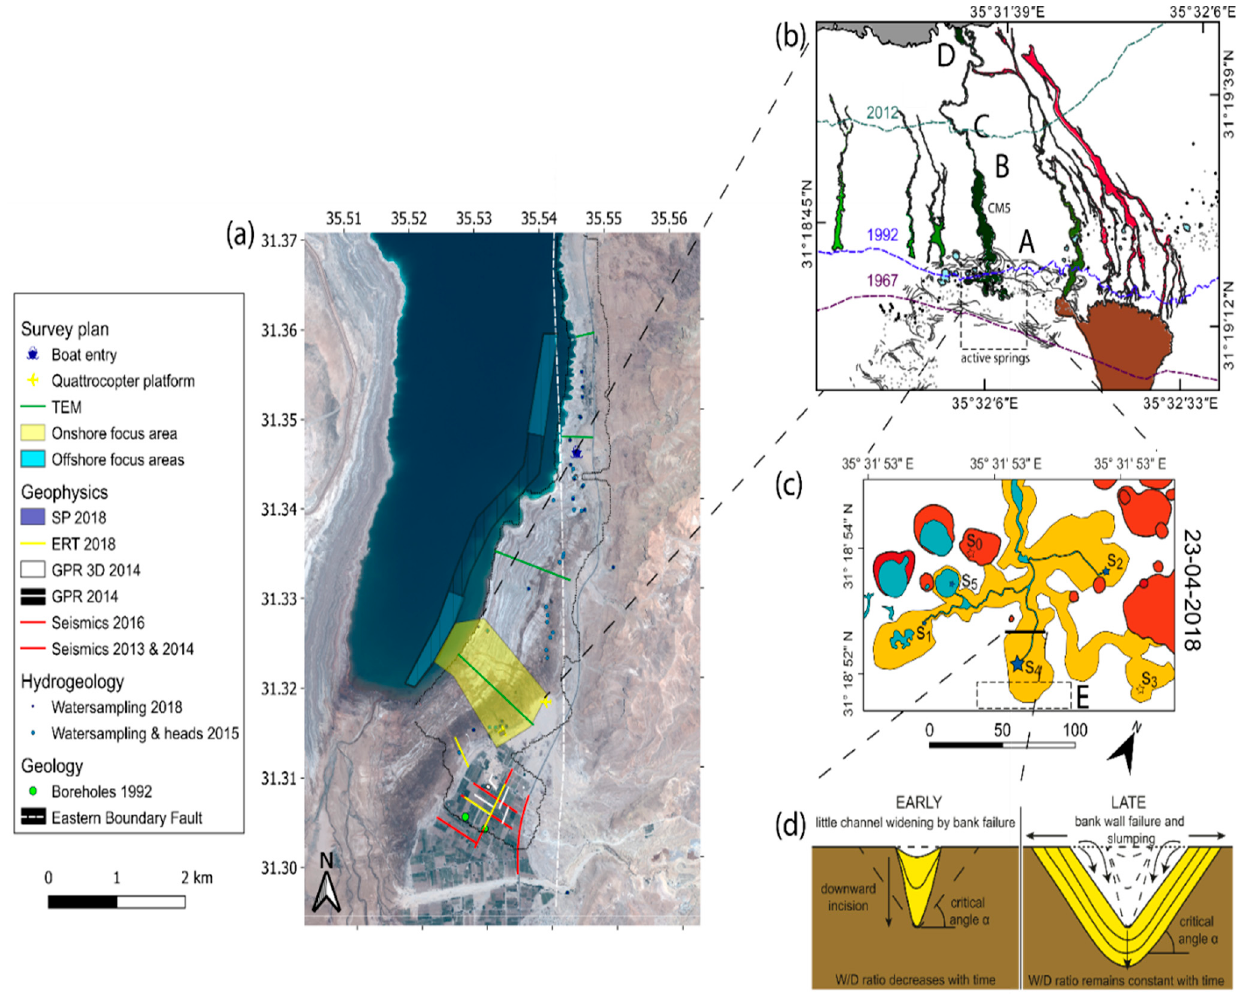
Figure 2. Geoscientific research proposal (MORFES) outline for the highlight area of the proposed UGGp. ( a ) Overview map of existing and planned surveys. Note that dashed line indicates previous drone and balloon surveys between 2014 and 2016. ( b ) Stream ‐ channel focus area of hydrochemical water and sediment sampling. A–D are focus areas for the meandering stream ‐ channel CM5. The shoreline retreat is indicated in this image. ( c ) Head of CM5 (yellow) focus area with springs s1–s5 and sinkholes (red). E marks location of longer ‐ term geoelectric measurements. ( d ) Conceptual profile showing stream ‐ channel widening. Maps b and c are modified after [26], scheme d after [48].